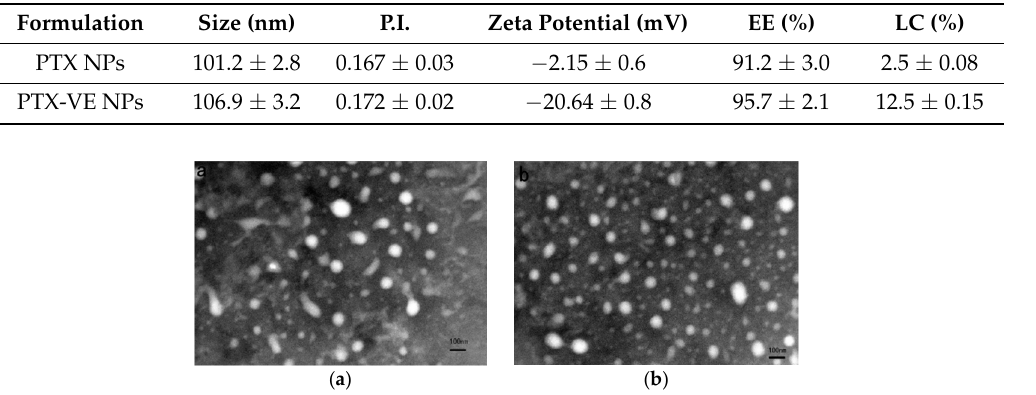
Figure 1. TEM image of PTX NPs ( a ) and PTX-VE NPs ( b ).